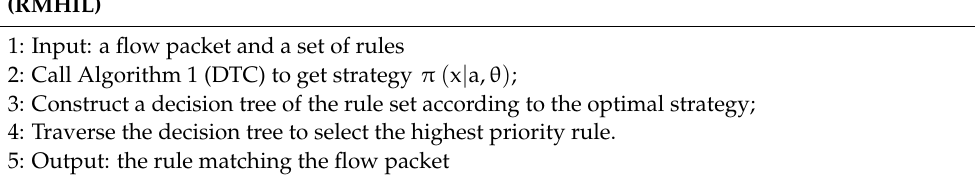
Algorithm 2: Rule Matching Algorithm based on Heterogeneous Integrated